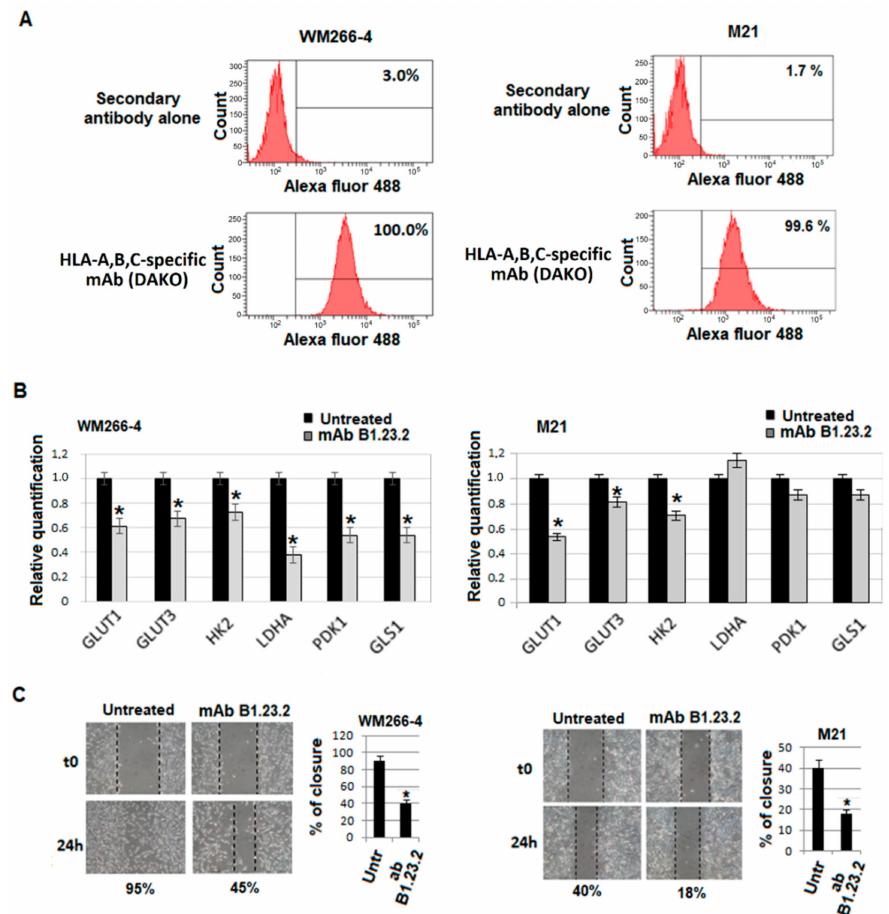
Figure 5. HLA-A,B,C expression on WM266-4 and M21 melanoma cells. WM266-4 (left panel) and M21 (right panel) melanoma cells were stained with the HLA-A,B,C-specific mAb purchased from DAKO and analyzed with a flow cytometer ( A ). Analysis of mRNA expression by quantitative real-time PCR of genes involved in metabolism in WM266-4 (left panel) and M21 (right panel) melanoma cells treated with the HLA-B,C-specific mAb B1.23.2 (10 µ g / mL) for 24 h at 37 ◦ C ( B ). Motility of WM266-4 and M21 melanoma cells in the presence of the HLA-B,C-specific mAb B1.23.2 (10 µ g / mL) for 24 h at 37 ◦ C ( C ). Values presented are the mean ± SEM of the results obtained in three independent experiments. * p <